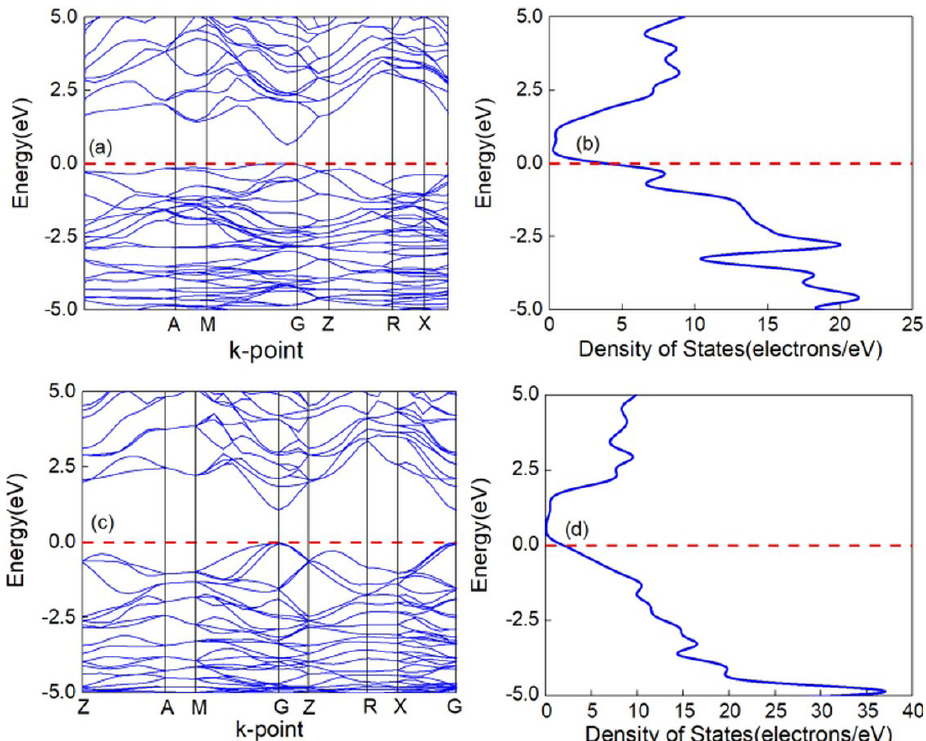
; (c)(d) Energy band diagram and density diagram of 2